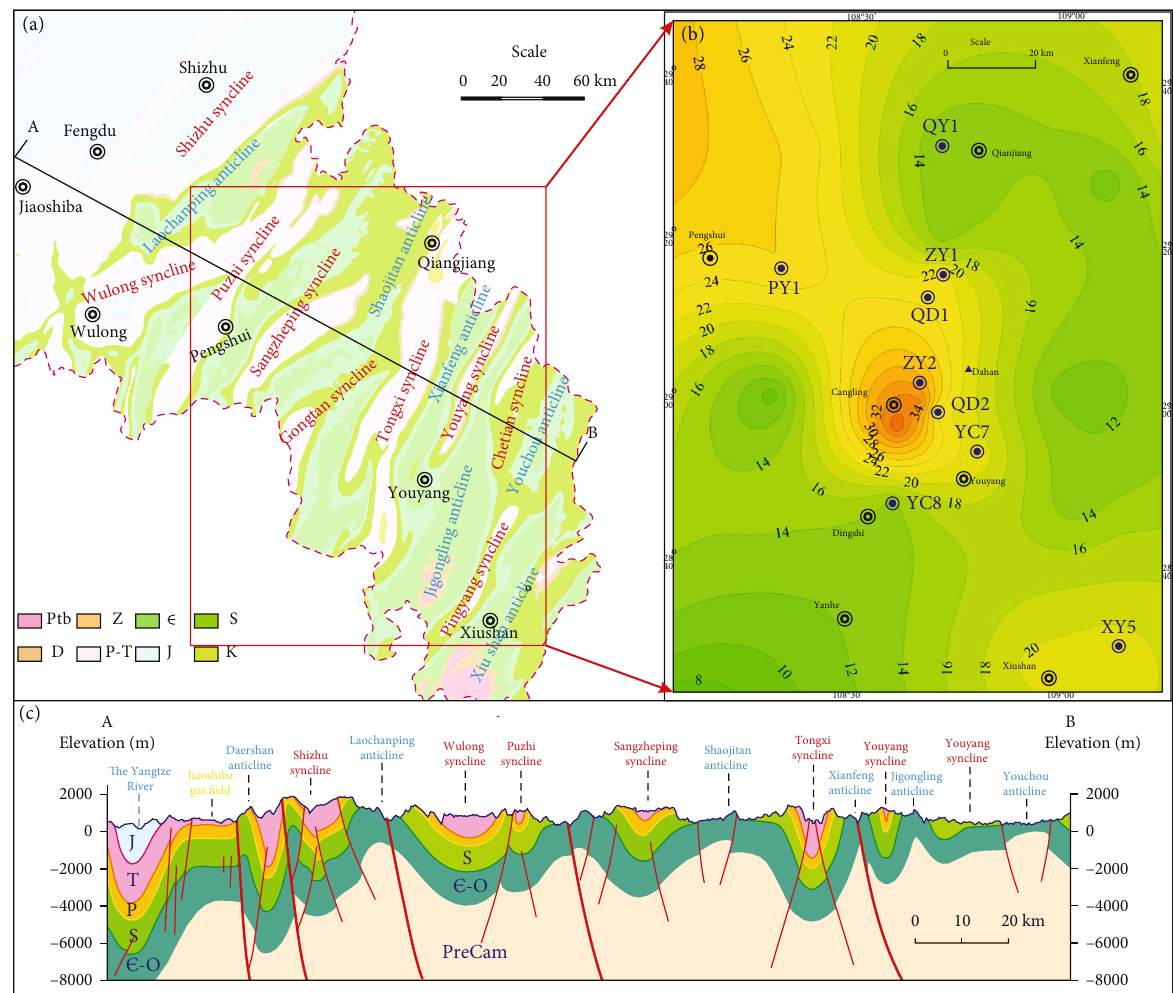
Figure 1: (a) Tectonic geological map of southeast Chongqing. (b) Thickness distribution map of high-quality shale in Wufeng-Longmaxi Formation, Qianjiang area. (c) Pro fi le of tectonic in southeastern